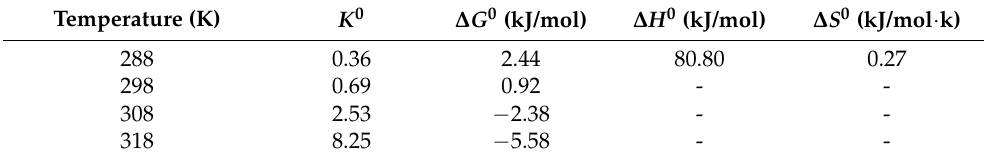
Table 1. Thermodynamic parameters for the adsorption of MB on 40% Tan/SA beads. Temperature (K) K 0